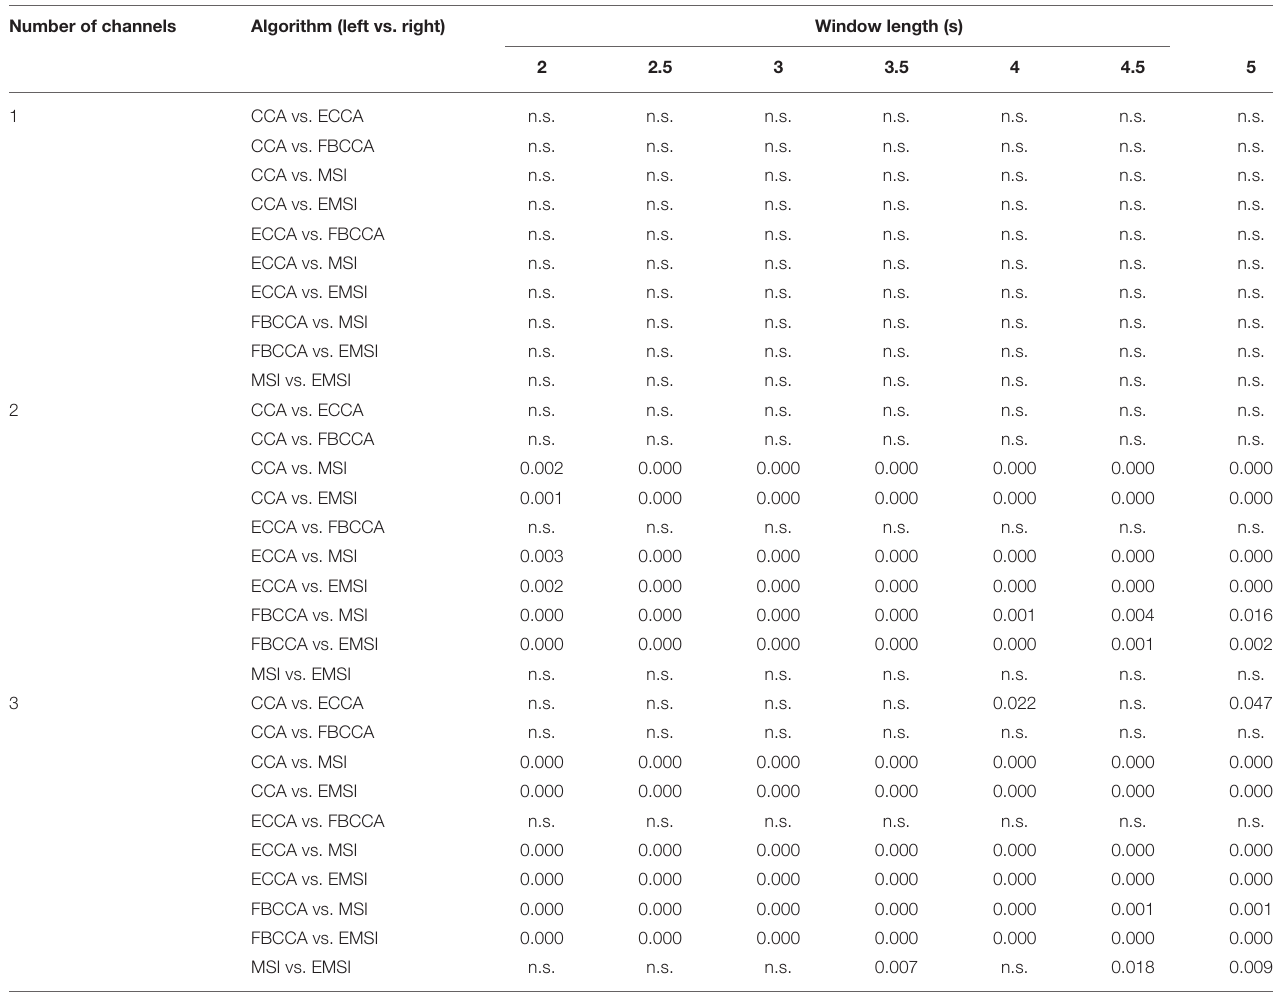
TABLE 5 | Bonferroni corrected p -values of post-hoc analysis among the robustness to electrode shift (RES) in four different algorithms for the number of channels and window lengths. Number of channels Algorithm (left vs.